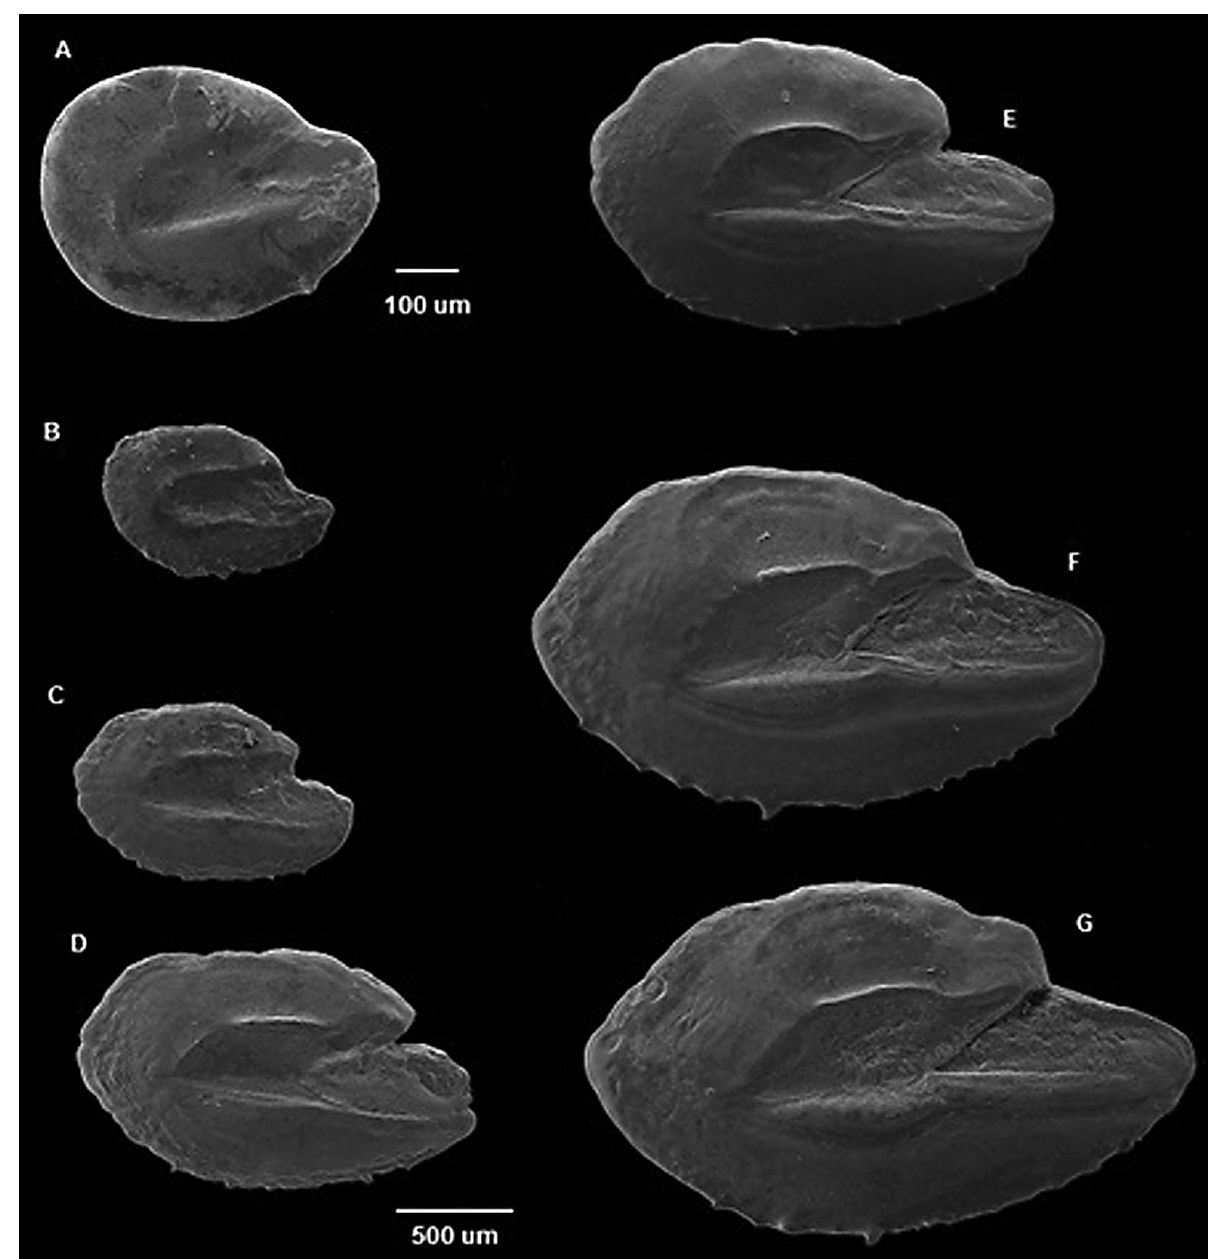
Fig. 3. – Micrographs of the inner face of the left sagitta otolith of Anchoa tricolor , with sizes of 22 mm (A), 34 mm (B), 40 mm (C), 55 mm (D), 65 mm (E), 75 mm (F) and 81 mm (G). Images A (120×; scale 100 µm) and B-G (45×; scale 500